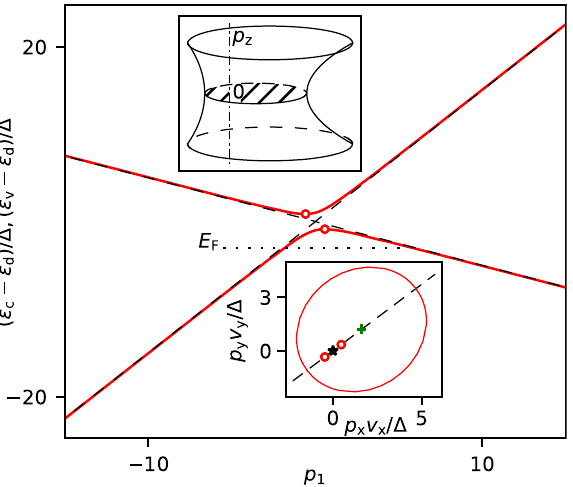
Fig. 2 | Magnetization of LaRhIn 5 . The dots are the experimental data 5 , the blue Fig.1|Theenergybands ε c ( p )and ε v ( p ),Eq.(1),inthevicinityoftheirnodalline line showsthe magnetization 2 produced by the nodalline in Fig.1,whereasthe red intheplane p z =0perpendiculartotheline. Theredsolidandblackdashedlines line is the magnetization of the Dirac pocket, with the background term show the bands with and without the spin – orbit interaction, respectively. The red − 0.7 Cg (1) B being added to Eq. (4). This term is determined by the charge χ circles mark the minimum of ε c ( p ) and the maximum of ε v ( p ) in the plane. The 0 B = = 2 carriers that are far away from the point p =0 2 . The inset is a zoom into the minimal indirect gap 2 Δ min =2 Δ ð 1 (cid:3) ~ a 2 ? Þ 1 determined by these two points is less region 2 ≤ B ≤ 4 than 2 Δ , the spin – orbit gap at p =0. Here p 1 (cid:2) ð a x p x + a y p y Þ = ð ~ a ? Δ Þ is the dimen- sionless quasimomentum measured along the vector ð ~ a x , ~ a y Þ in the plane with the = 2 coordinates p x v x / Δ and p y v y / Δ ; ~ a i (cid:2) a i = v i , and ~ a ? (cid:2) ð ~ a 2 x + ~ a 2 y Þ 1 . The dotted line indicatestheFermilevel E F .Upperinset:TheFermisurfaceenclosingthenodalline (thedash-dottedline)at( E F − ε d ) b <0.Lowerinset:Thecrosssection(ellipse)ofthe Fermi surface on the plane p z =0. The black dashed line marks the direction along which the bands are shown in the main panel. The black asterisk and green cross mark the point p =0 and the center of the ellipse, respectively.